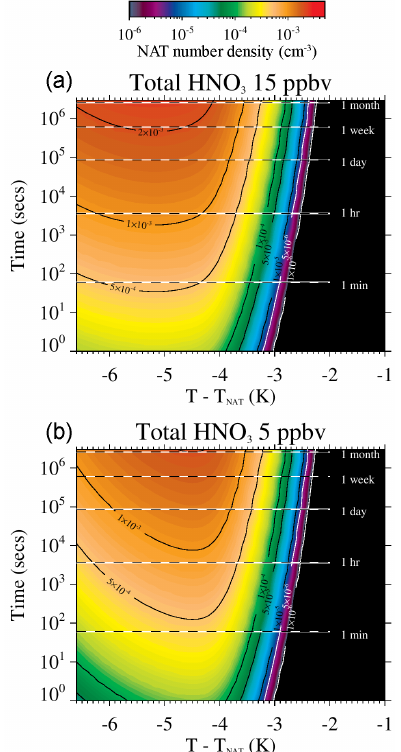
Figure 1. (a) Calculated NAT number densities (colored shading and labeled contour lines) resulting from varying temperature ex- posure durations in an unperturbed atmosphere with 15ppbv to- tal HNO 3 . Horizontal dashed lines highlight exposures of between 1min and 1 month. An air parcel (containing the requisite back- ground aerosol embedded with foreign nuclei) exposed to a tem- perature of T − T NAT = − 4K for 1 day will generate 0.0012cm − 3 of nucleated NAT particles. (b) As for (a) except for a denitrified atmosphere with 5ppbv total HNO 3